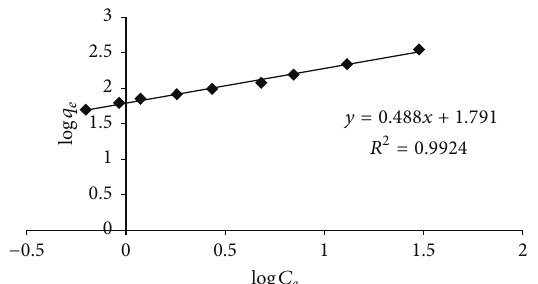
Figure 5: Freundlich adsorption isotherm for RO16 onto MKCF at 30 ∘ C.